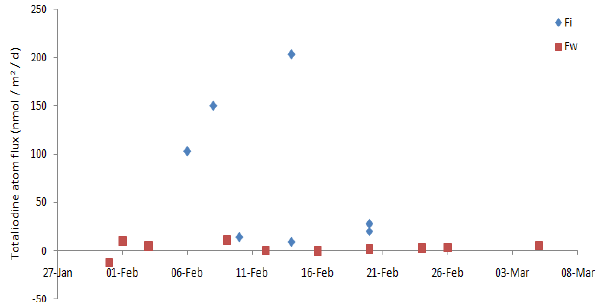
Fig. 14. Total iodine atom flux to the atmosphere, based on the sum of all fluxes of iodocarbons from ice, F i , and water, F w , assuming atmospheric halocarbon concentrations maintain a steady state.